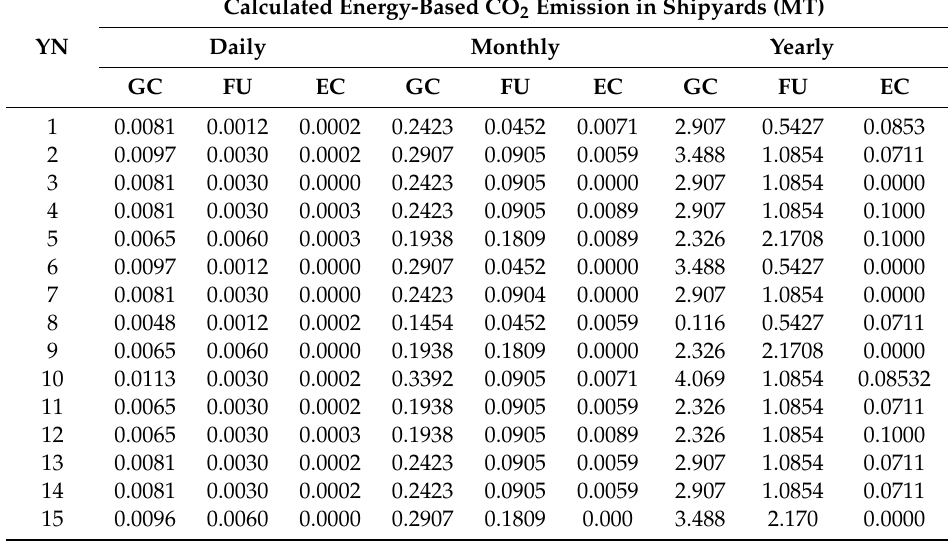
Table 2. Calculation of CO 2 emission from 15 shipbreaking yards, daily, monthly and yearly from three shipbreaking activities. i.e., gas cutting (GC), fuel use (FU) and electricity consumption (EC). Calculated Energy-Based CO 2 Emission in Shipyards (MT) Daily Monthly YN